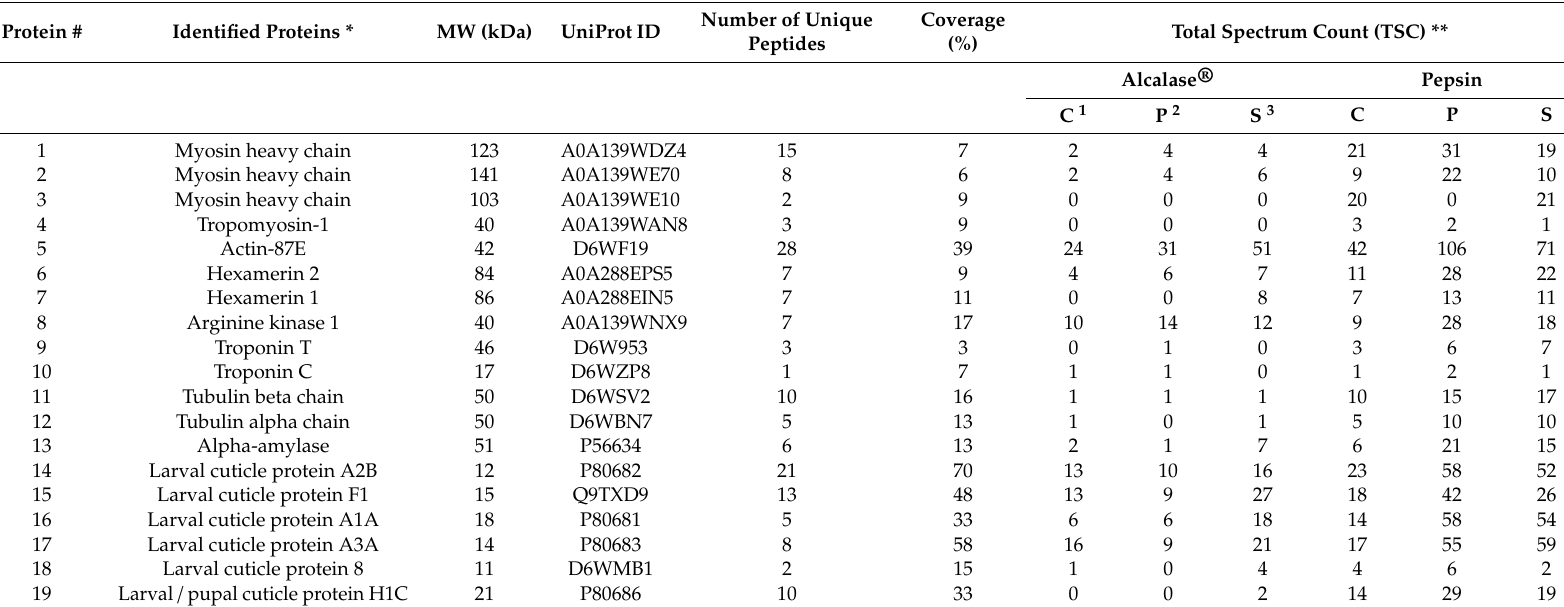
Table 1. Mealworm allergenic protein precursors from peptides generated after Alcalase ® and pepsin in vitro digestion of mealworm